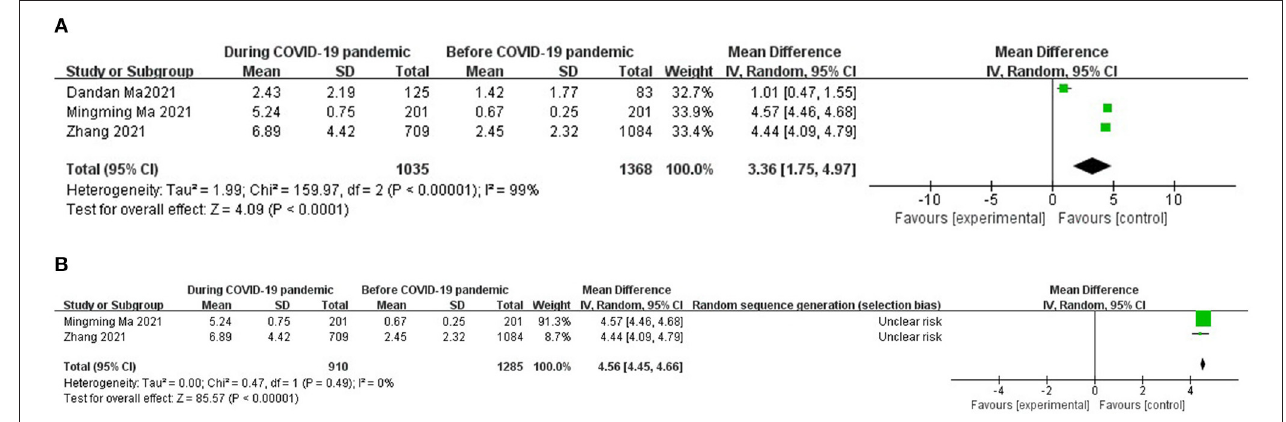
FIGURE 4 | (A) Forest plots for comparison of digital screen devices time between COVID-19 pandemic and before it. (B) Sensitivity analysis for comparison of digital screen devices time between COVID-19 pandemic and before it.